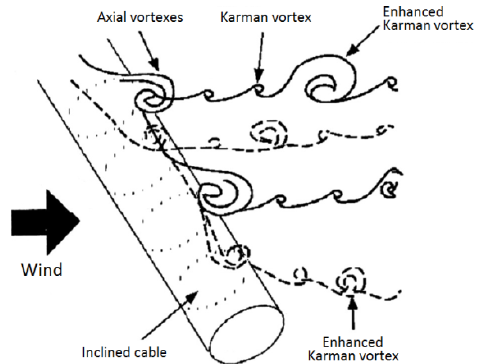
Fig. 4 . Interaction of axial vortexes with Karman vortexes in a wake of inclined cable